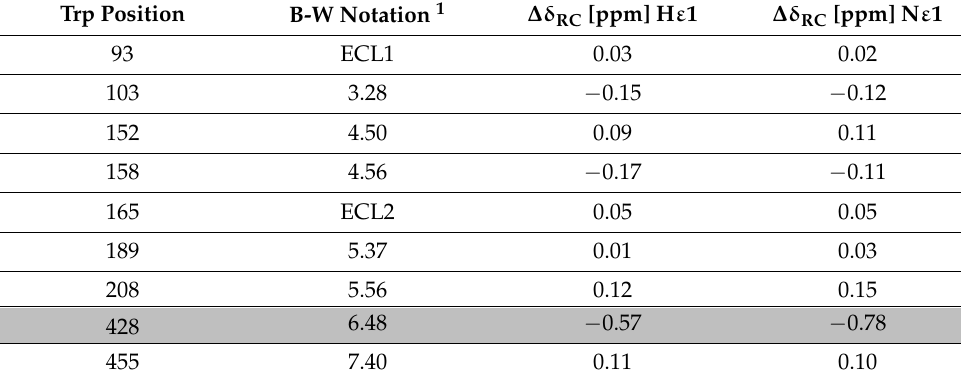
Table 2. Calculated tryptophan indole 15 N and 1 H ring current shifts using the structure of H 1 R in complex with doxepin (PDB ID 3RZE). Calculated ring current shifts for the conserved “toggle switch” tryptophan, Trp 6.48 , are highlighted in the grey